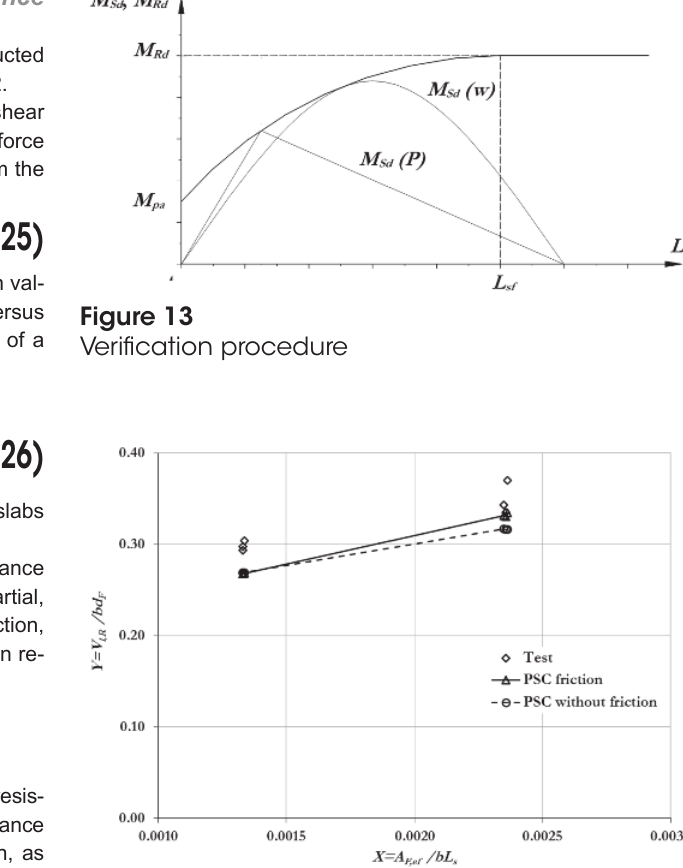
Characteristic shear resistance of specimens of